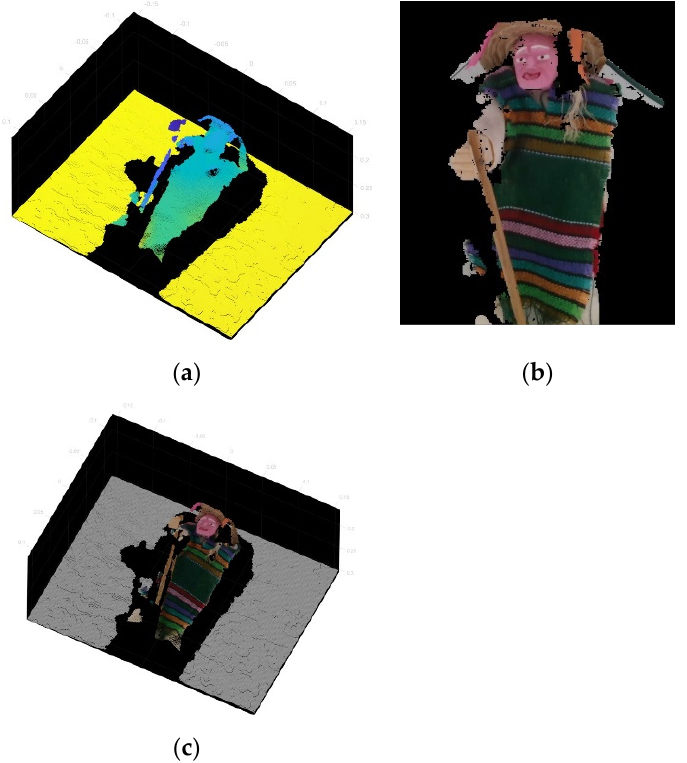
Figure 2. Point cloud color map registration: ( a ) depth information; ( b ) color information; ( c ) colored point cloud through RGB registration.